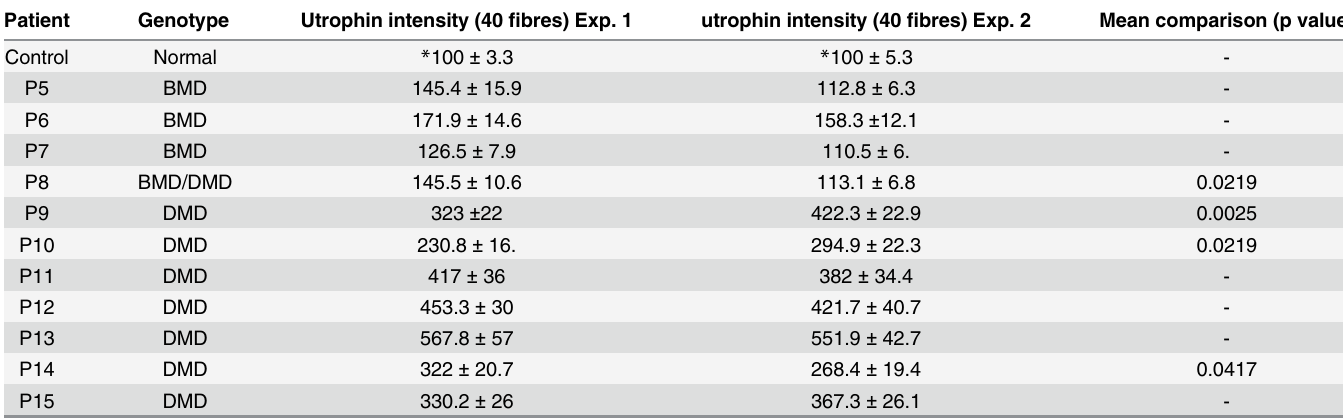
Table 2. Normalised utrophin intensity (mean ± standard error of mean).